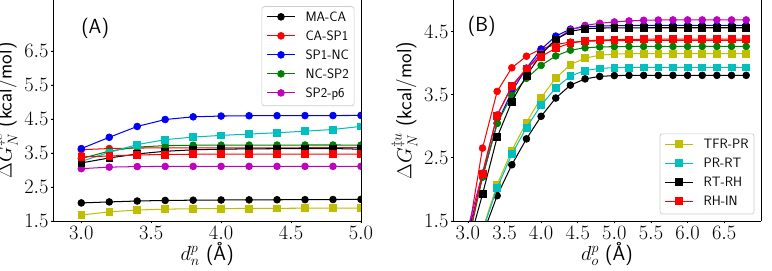
Figure 5. Free energy of NAC formation ( A ) for all enzyme-bound ( ∆ G ‡ c ( ∆ G ‡ u ) substrate systems when varying the threshold d p n and d p o that partitions bound and unbound N nucleophilic water states,